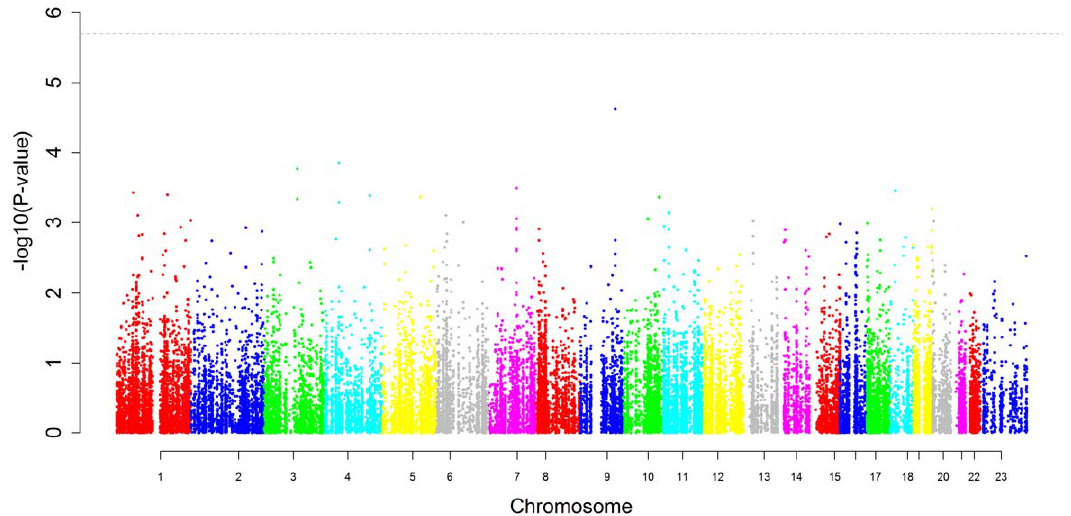
Figure 3. Manhattan plot for apnea hypopnea index in the European ancestry population. This figure plots the association results for all SNPs against log(apnea hypopnea index + 1) among those of European ancestry. The y-axis displays the -log(p-value), the x-axis the SNP position on each chromosome. The dotted line represents the threshold for statistical significance based on the number of independent comparisons being made.